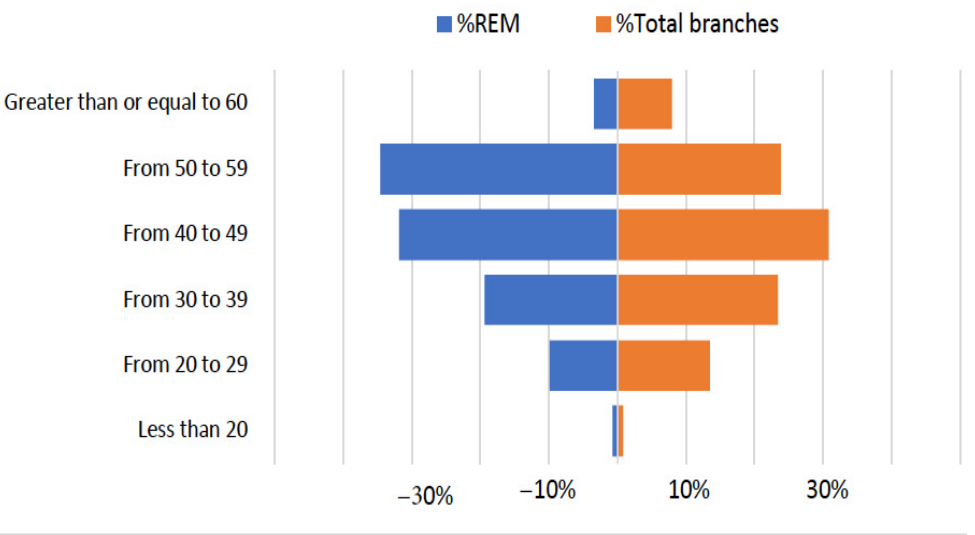
Figure 6. Population pyramid of the ages of workers affiliated to the REM and to the total SS branches in the Spanish Mediterranean in 2020 9 .